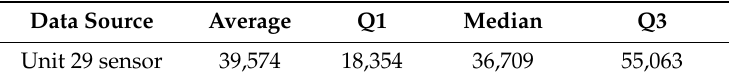
Table 1. Descriptive Statistics for Electric Power Data (Unit: